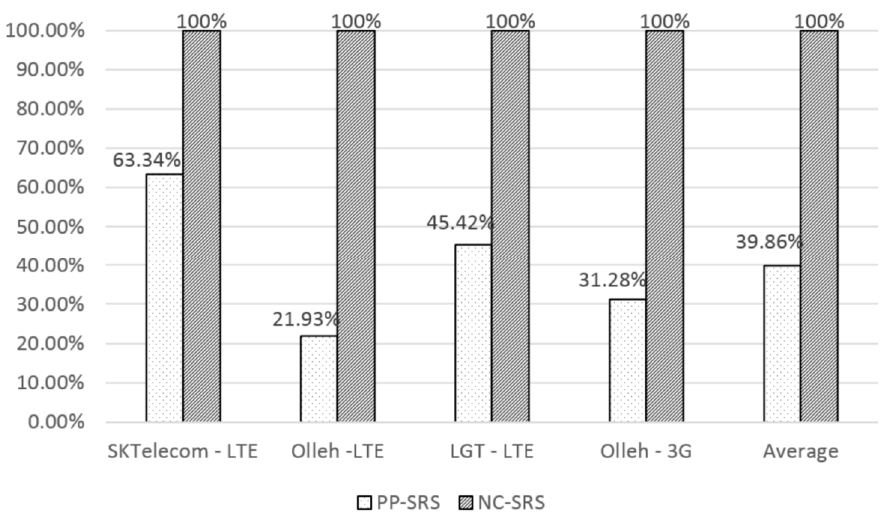
Figure 14. Comparison of the service provision rates of each carrier using PP-SRS and NC-SRS.